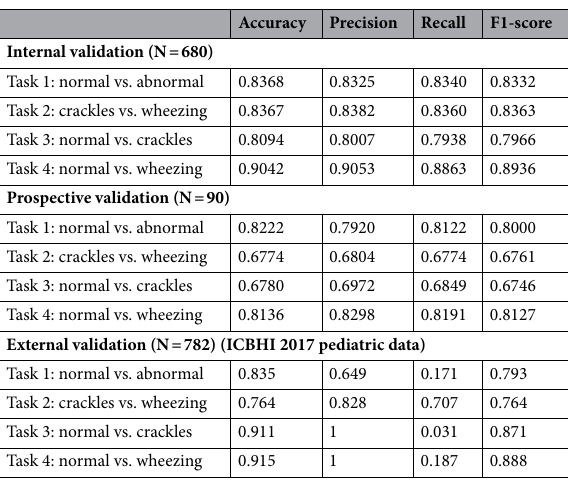
Table 3. Model performance during internal validation, prospective validation, and external validation. ICBHI International Conference on Biomedical and Health Informatics 2017 Challenge Respiratory Sound Database.